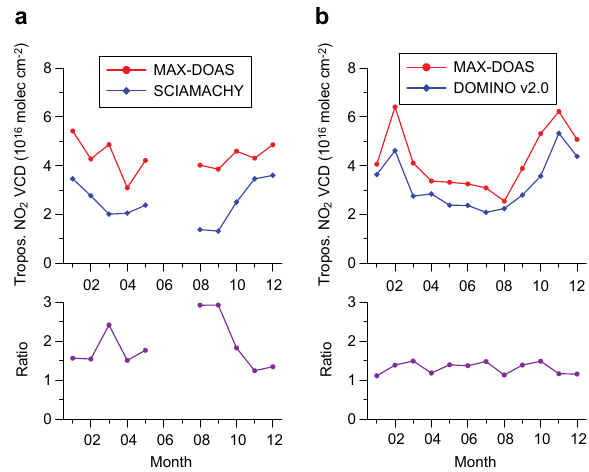
Fig. 15. Comparisons of the seasonal variation in the tropospheric NO 2 VCD over Beijing measured by ground-based MAX-DOAS with (a) coincident SCIAMACHY satellite data (2008–2010) and (b) coincident OMI satellite data (DOMINO v2.0, 2008–2011). Both the absolute VCD values from MAX-DOAS and satellite mea- surements (top) and their ratios (bottom) are